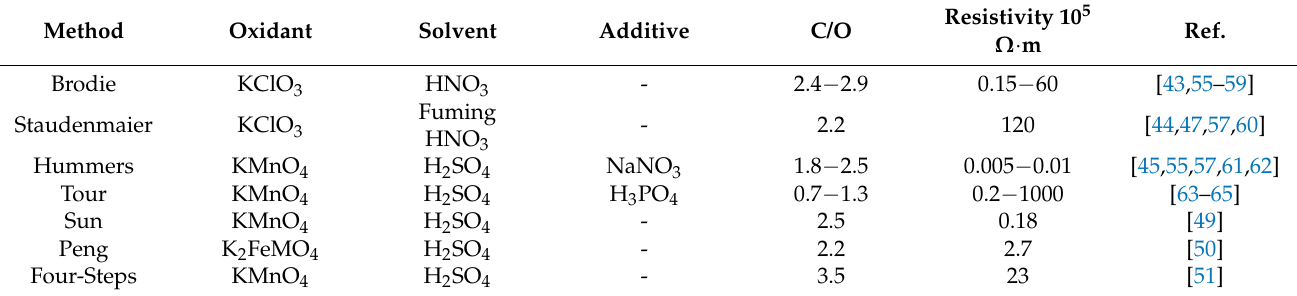
Table 1. Overview of the significant synthetic processes associated with the manufacture of GO